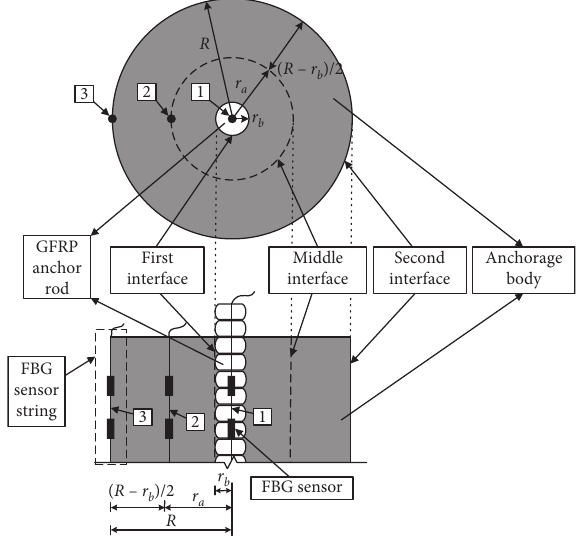
Figure 3: Arrangement of FBG sensor strings. Note. r radius of the middle interface; r b denotes the radius of the first interface; R denotes the radius of the second different, the data processing approach is the same for the three sensor strings.